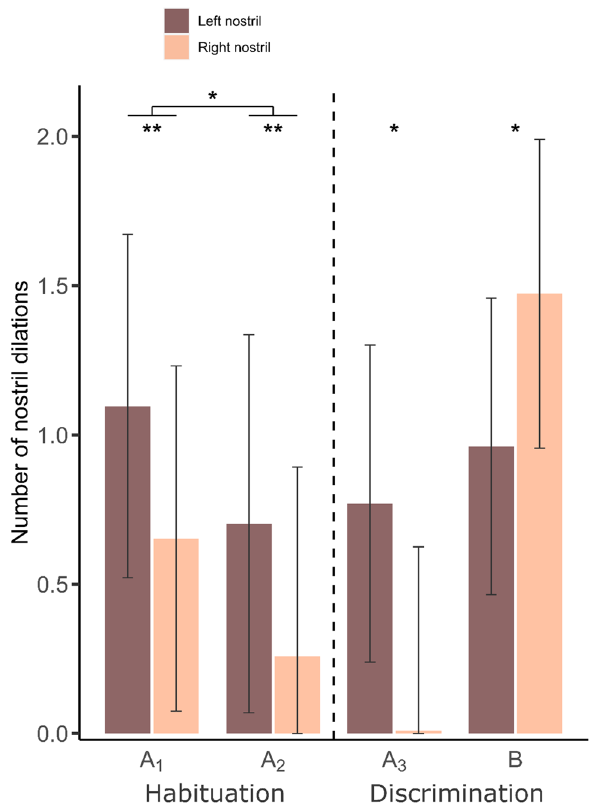
Figure 5. Differential use of the left and right nostrils when sniffing odors. The graphs are extracted from the corresponding models presented in Table 2 (see “Methods” section). The error bars represent the standard errors from the models. * p ≤ 0.01,** p ≤